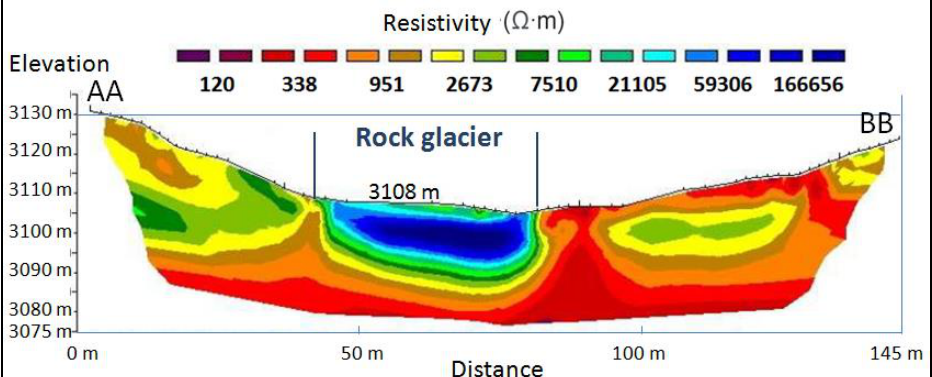
Figure 6. Transversal electrical tomography of Corral del Veleta (August 2009). In blue, the thickness of the frozen bodies, with a mean value of 10 m. The rock glacier is situated over it [29].